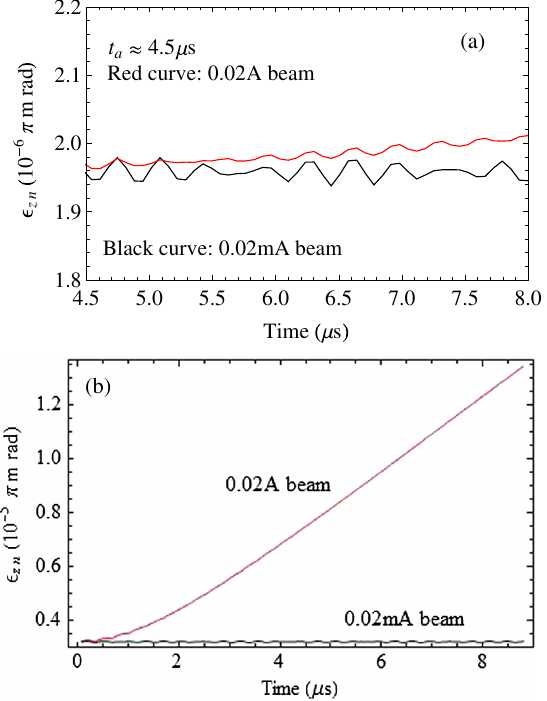
ð t (cid:6) t Þ plot for a 0.02 mA low current Rb beam FIG. 9. (a) (cid:1) zn a (black curve) after the one-step correction is compared with a is the moment when 0.02 A high current Rb beam (red curve). t a the beam completely left the last gap. (b) Compares the longi- tudinal emittance growth due to the head-to-tail nonlinearity of a 0.02 mA low current Rb beam (black curve) with a 0.02 A high current Rb beam (red curve).FIG. 8. v